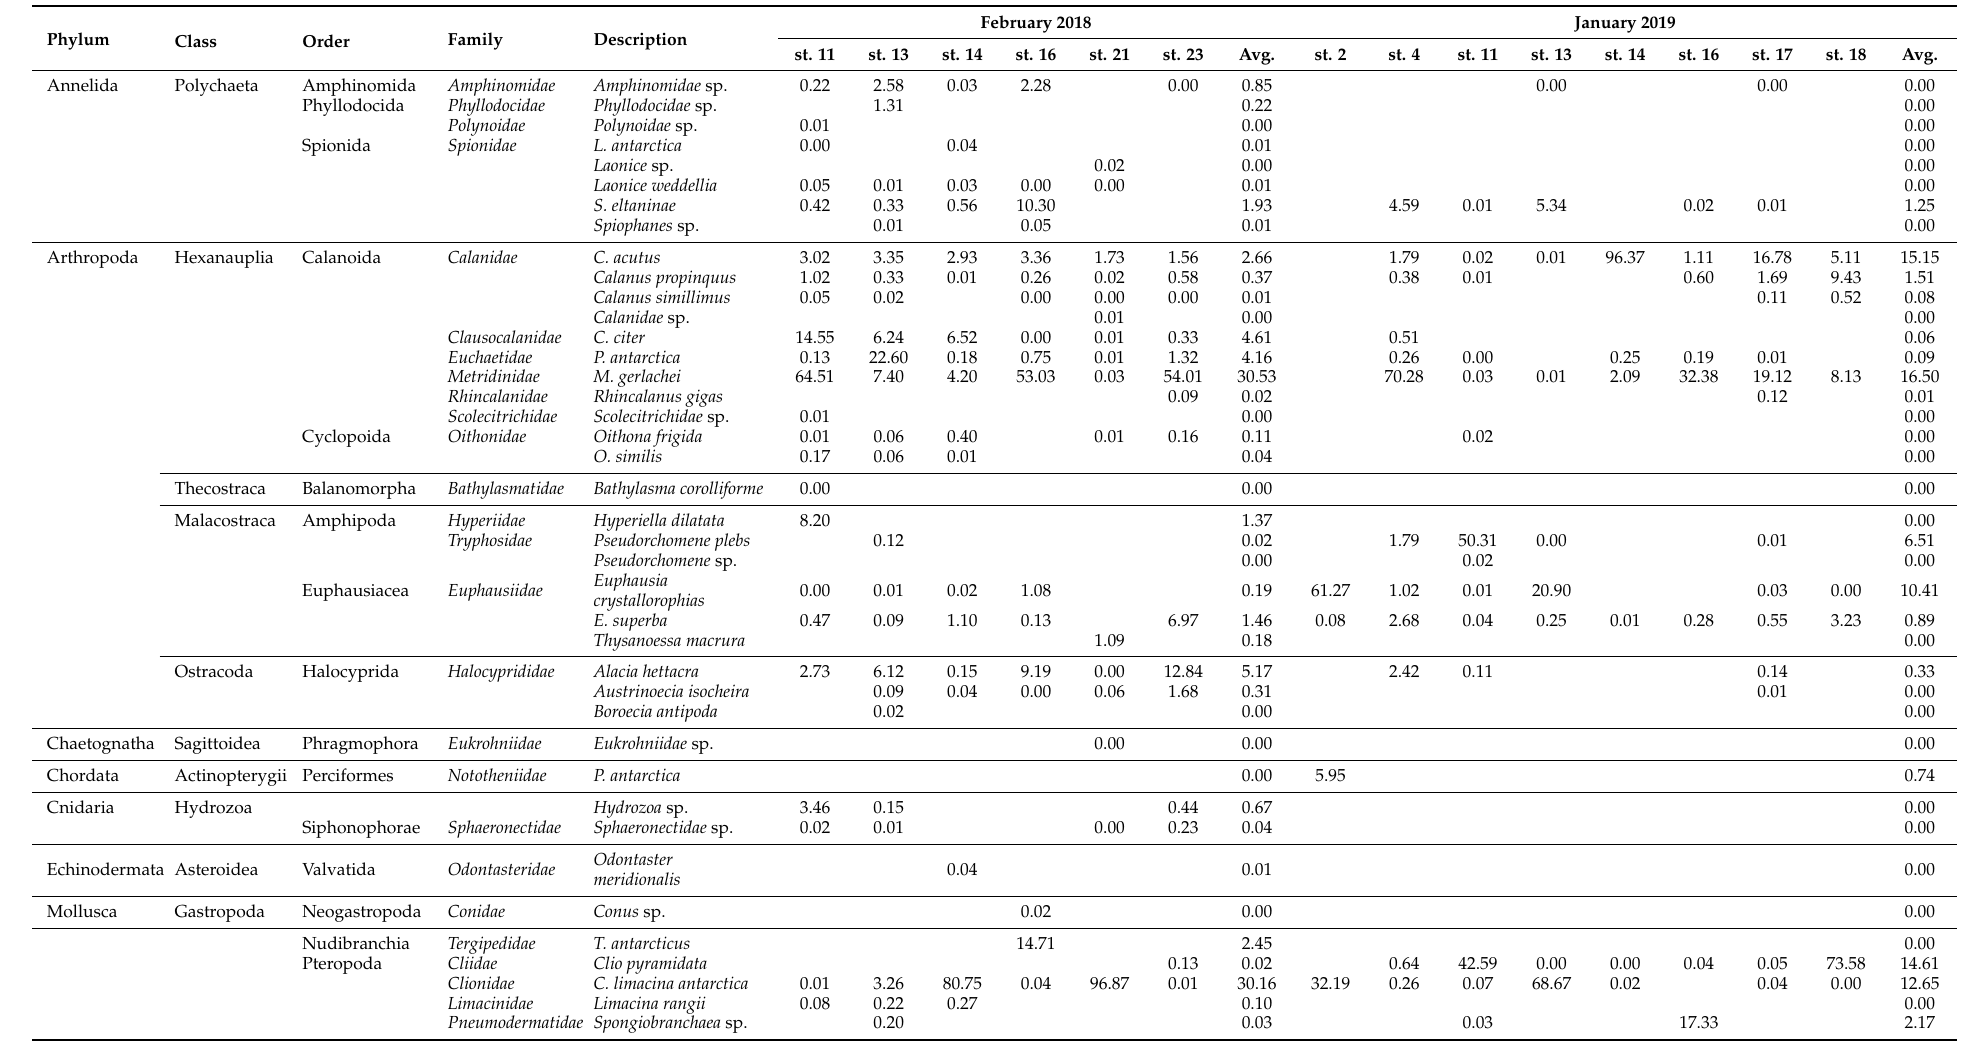
Table 2. Relative proportions of identified species by mini-read barcoding (MB) in 2018 and